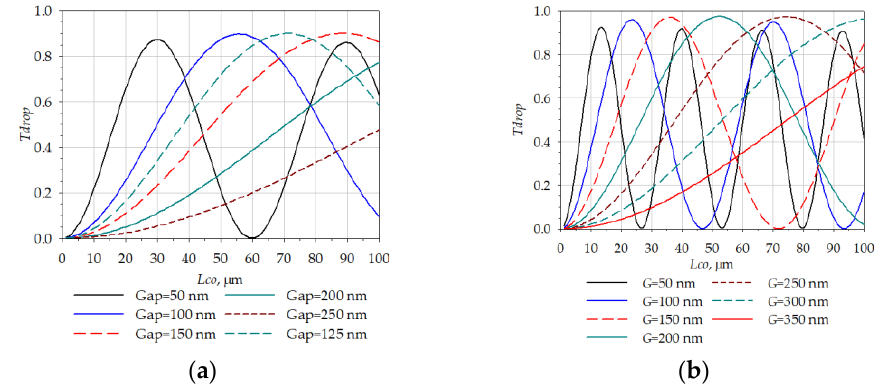
Figure 9. Dependence of the optical transmission coefficient on the coupling length for the OMT with single-plane waveguides (Scheme 2). ( a ) Waveguides with dimensions of 300 × 1000 nm; ( b ) Waveguides with dimensions of 300 × 750 nm.